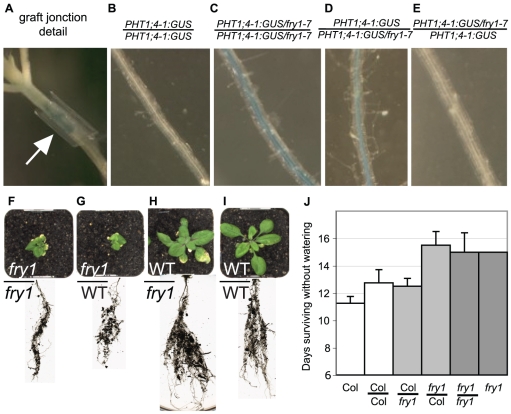
FRY1 in shoot complements the root growth defects of fry1 but not the expression of the PHT1;4:GUS reporter gene.(A) The grafting junction. Arrow indicates the silicon ring. (B–E) The different graft combinations (scion/root) between the PHT1;4:GUS line and the PHT1;4:GUS line are indicated. Below are the corresponding pictures of a grafted root after the overnight GUS staining. (F–I) Shoot and root phenotypes of the different graft combinations (scion/root) between the wild type and the fry1 mutant, after 4 weeks of growth in soil. Note that the root growth of fry1 is complemented by the wild type shoot (H), but wild type roots display a fry1 phenotype when grafted with a fry1 scion (G). (J) Survival rate after withholding watering of plants with different grafting combinations show that the drought tolerance phenotype of fry1 is determined by the scion genotype. Data are from one representative experiment out of three. Error bars represent standard error.